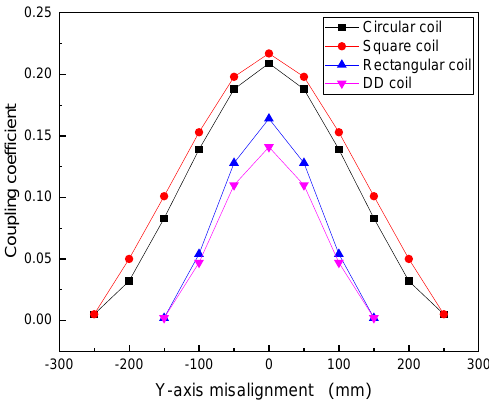
Figure 7. Coupling coefficient versus the Y -axis misalignment.